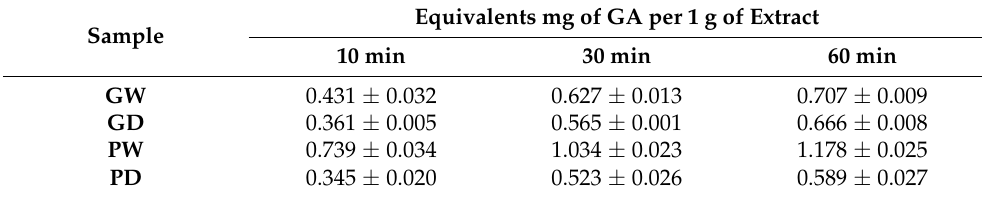
Table 4. Antioxidant power of the extracts after 6 months storage at 4 ◦ C in the dark, expressed as equivalent GA mg ± SE at 10, 30 and 60 min per 1 g of extract ( n =